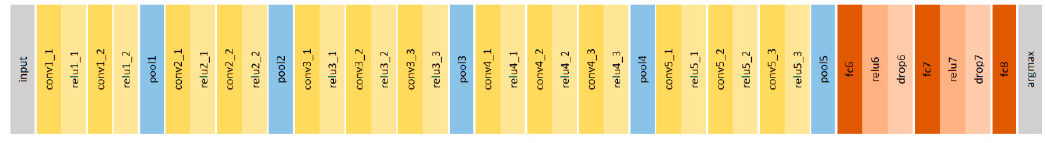
Figure 4. VGG16 feature extractor.